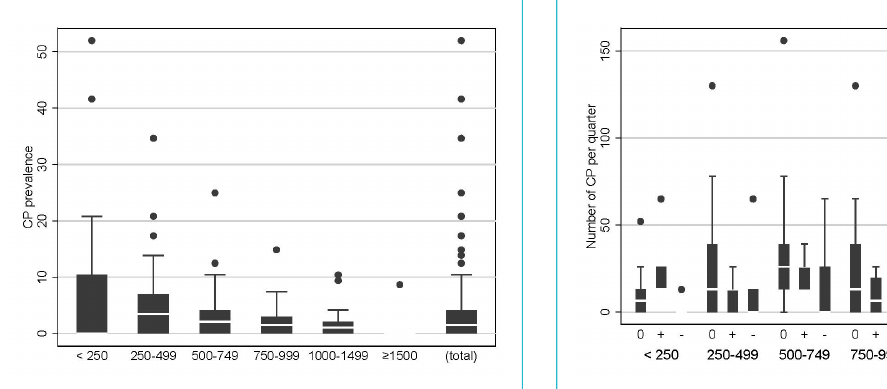
Figure 1: Monte Carlo simulation based on number of patients with paediatric chronic pain (PCP) in the last 7 days.